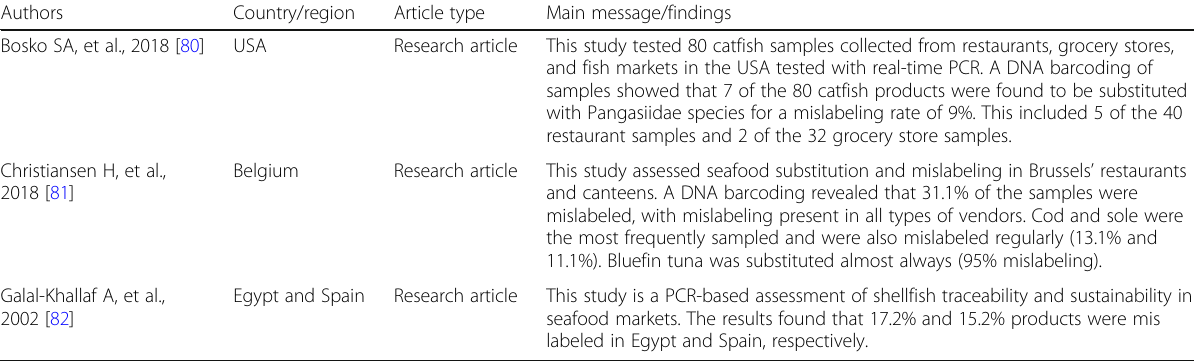
Table 7 Summary of full-text articles which reported mislabeling as a public risk in food marketing (Continued)